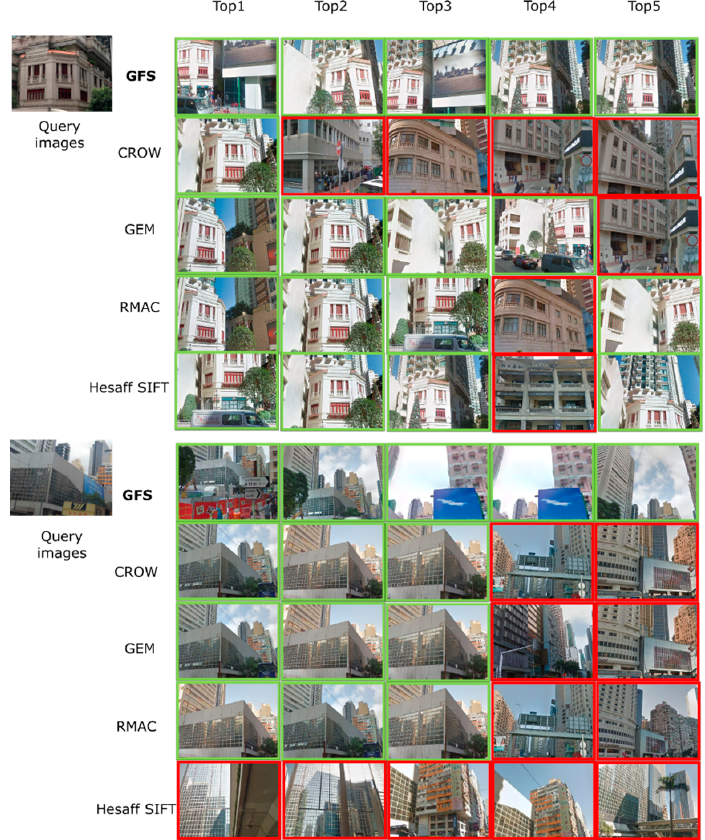
Figure 11. Comparison of the results with other methods. The green boxes are the correct result, while the red boxes are the incorrect result. Top1 refers to the image most similar to the query image, and so on.